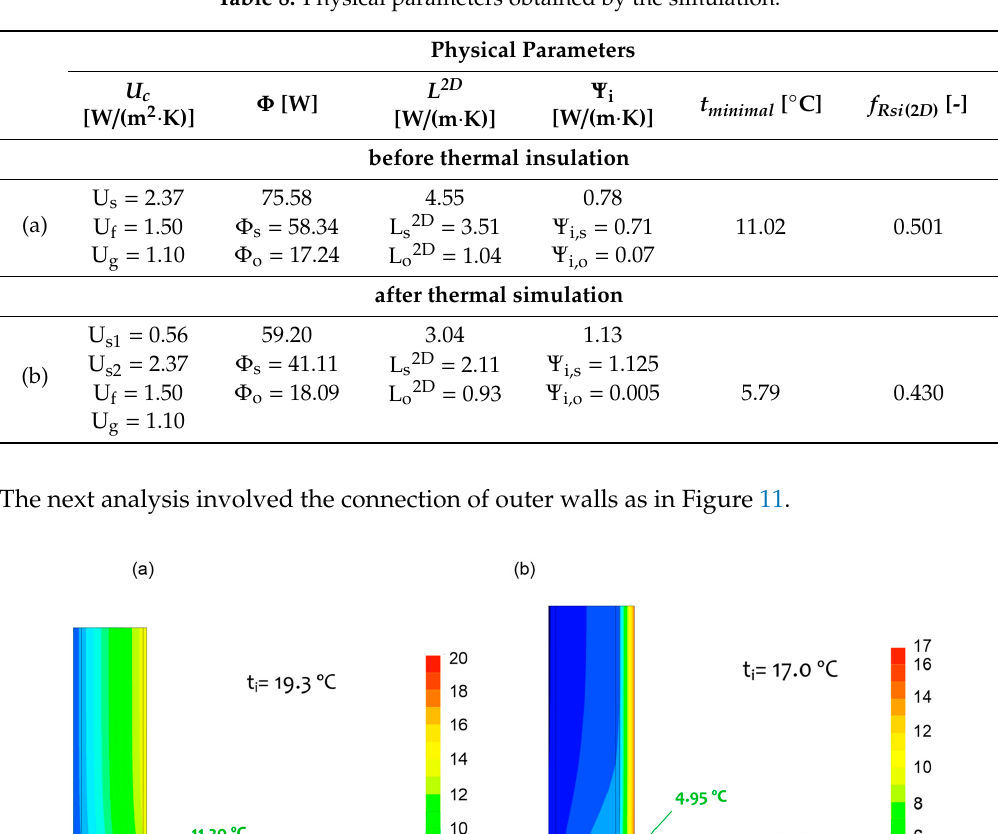
Table 8. Physical parameters obtained by the simulation.